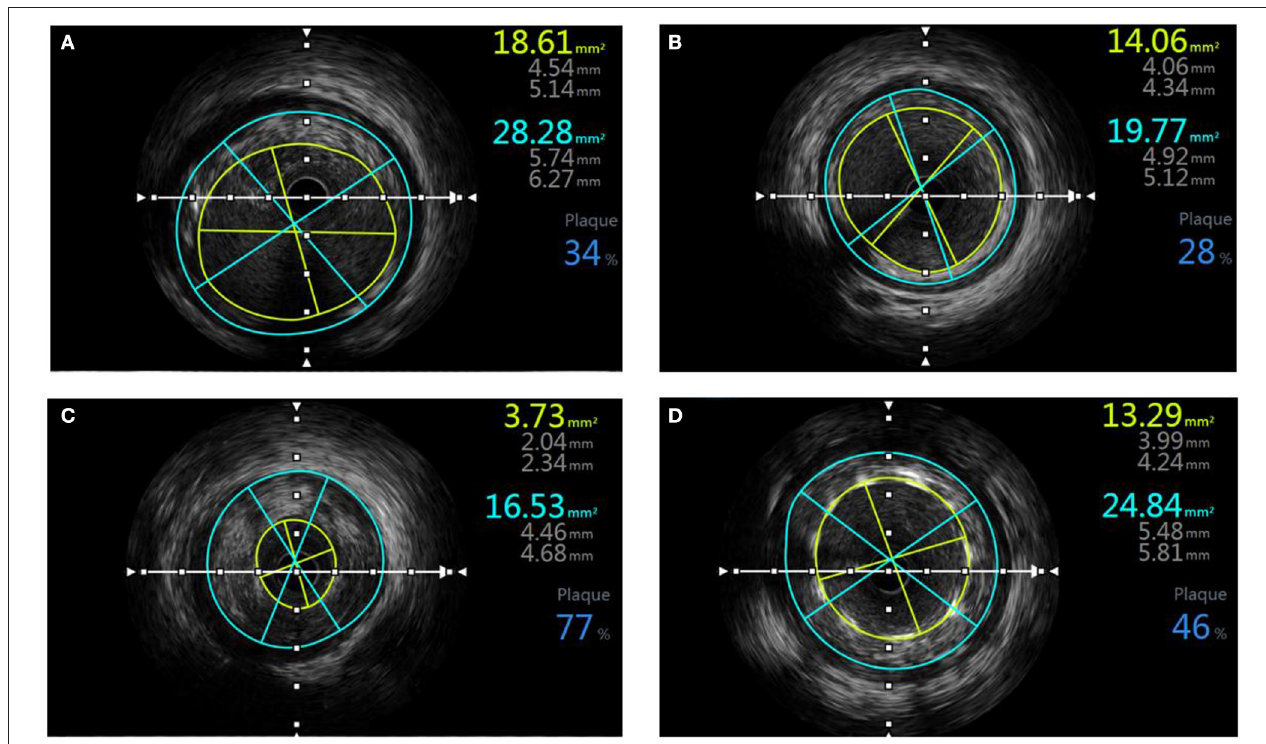
FIGURE 1 | An example of IVUS imaging and analysis of stent expansion. (A) EEM CSA and lumen CSA of proximal normal-looking segment; (B) EEM CSA and lumen CSA of distal normal-looking segment; (C) EEM CSA and lumen CSA of minimal culprit segment; (D) EEM, CSA, and MSA after stenting, the stent expansion is 13.29/[(14.06 + 18.61)/2] x 100 = 82.4%. EEM, external elastic membrane; CSA, crosssectional area; MSA, minimum stent cross-sectional